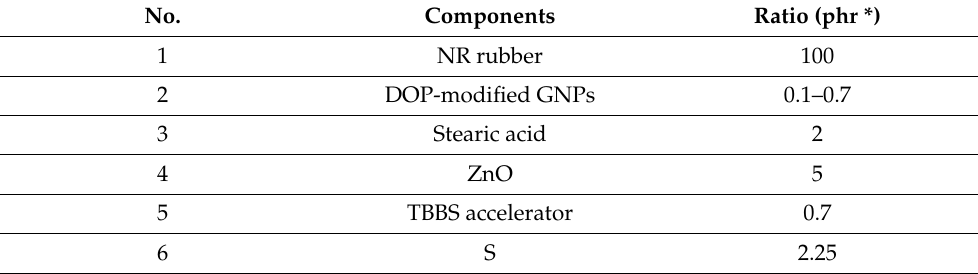
Table 1. The composition of the DOP-modified GNPs/NR composite.